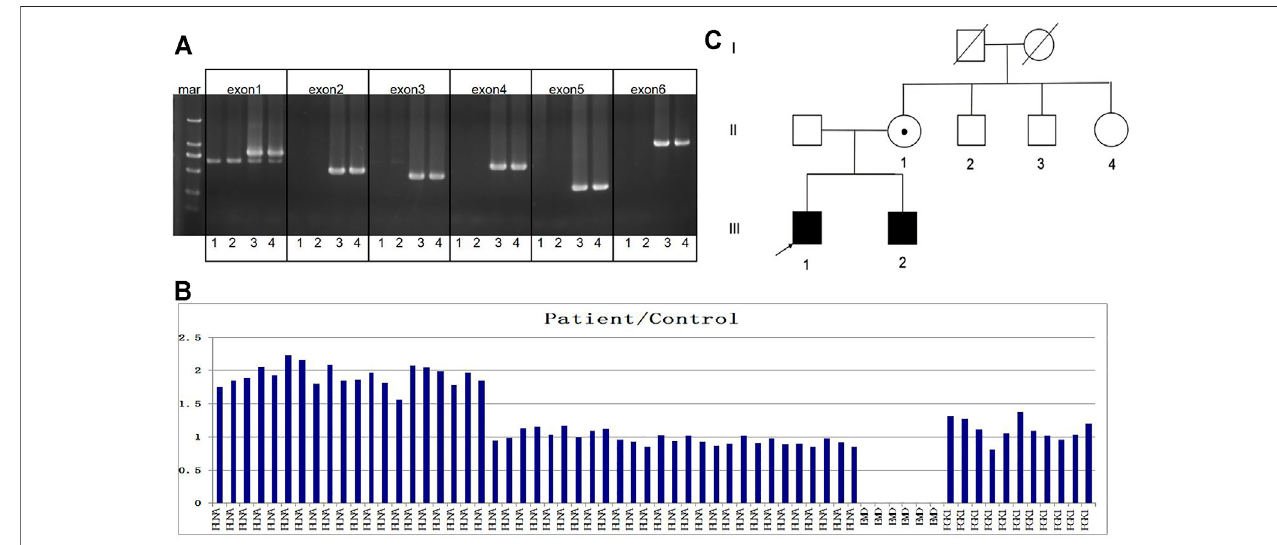
FIGURE 2 | Family pedigree and genetic results. (A) In the gel, numbers 1 to 4 represent the proband, his brother, his mother, and the control, respectively. The targetbands of EMD exons1 – 6were deleted inthe proband and his brother. (B) Column chart shows ratios between thepatientand thecontrol patientsin terms ofthe number of reads, suggesting the deletion of exons 1 – 6 of EMD and the duplication of exons 29 – 48 of FLNA in the proband. (C) Family pedigree is shown.